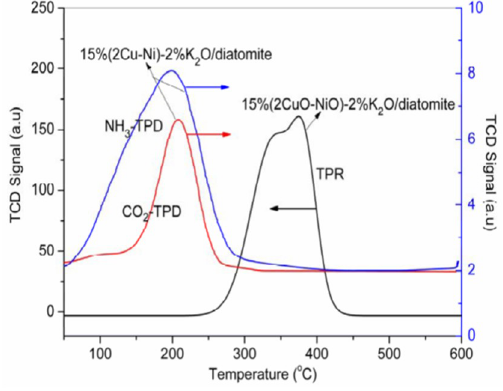
Figure 2 . TPR, CO 2 –TPD and NH 3 –TPD of 15CN2K/diatomite.